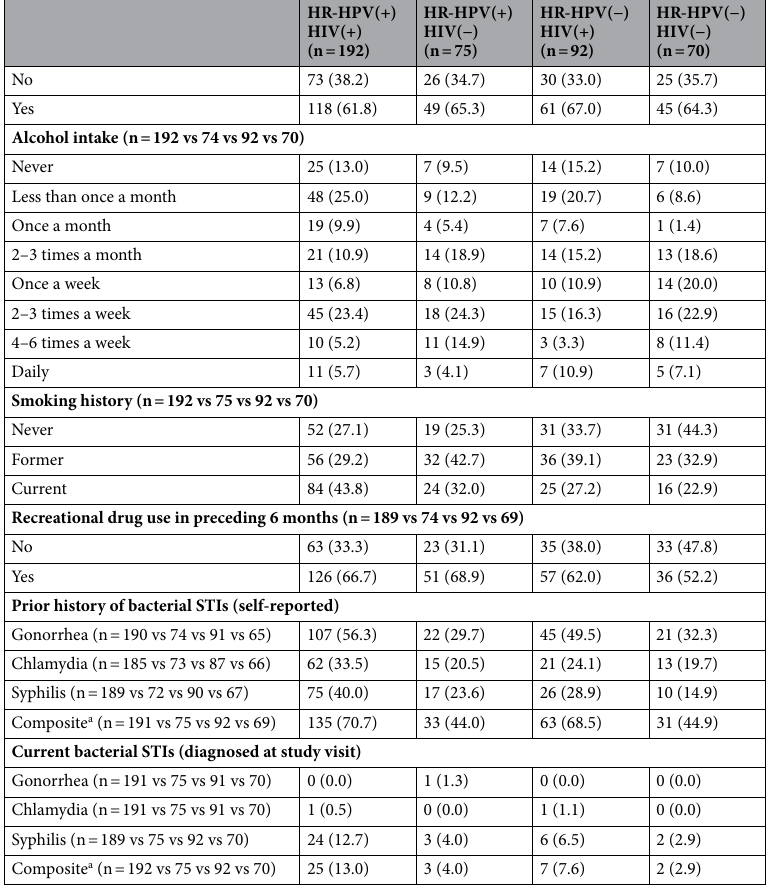
Table 1. Study population characteristics by HR-HPV status. IQR interquartile range. a Composite means any of: gonorrhea, chlamydia or syphilis. Total datapoints for each corresponding variable are indicated. Missing data from the questionnaire were due to either “don’t know” or “refuse to answer” as the response. Some laboratory data were missing for some participants.